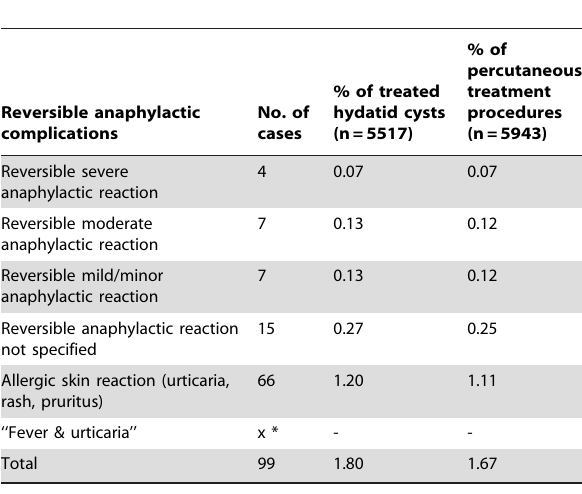
Table 7. Overall reversible anaphylactic reactions due to percutaneous treatment of hydatid